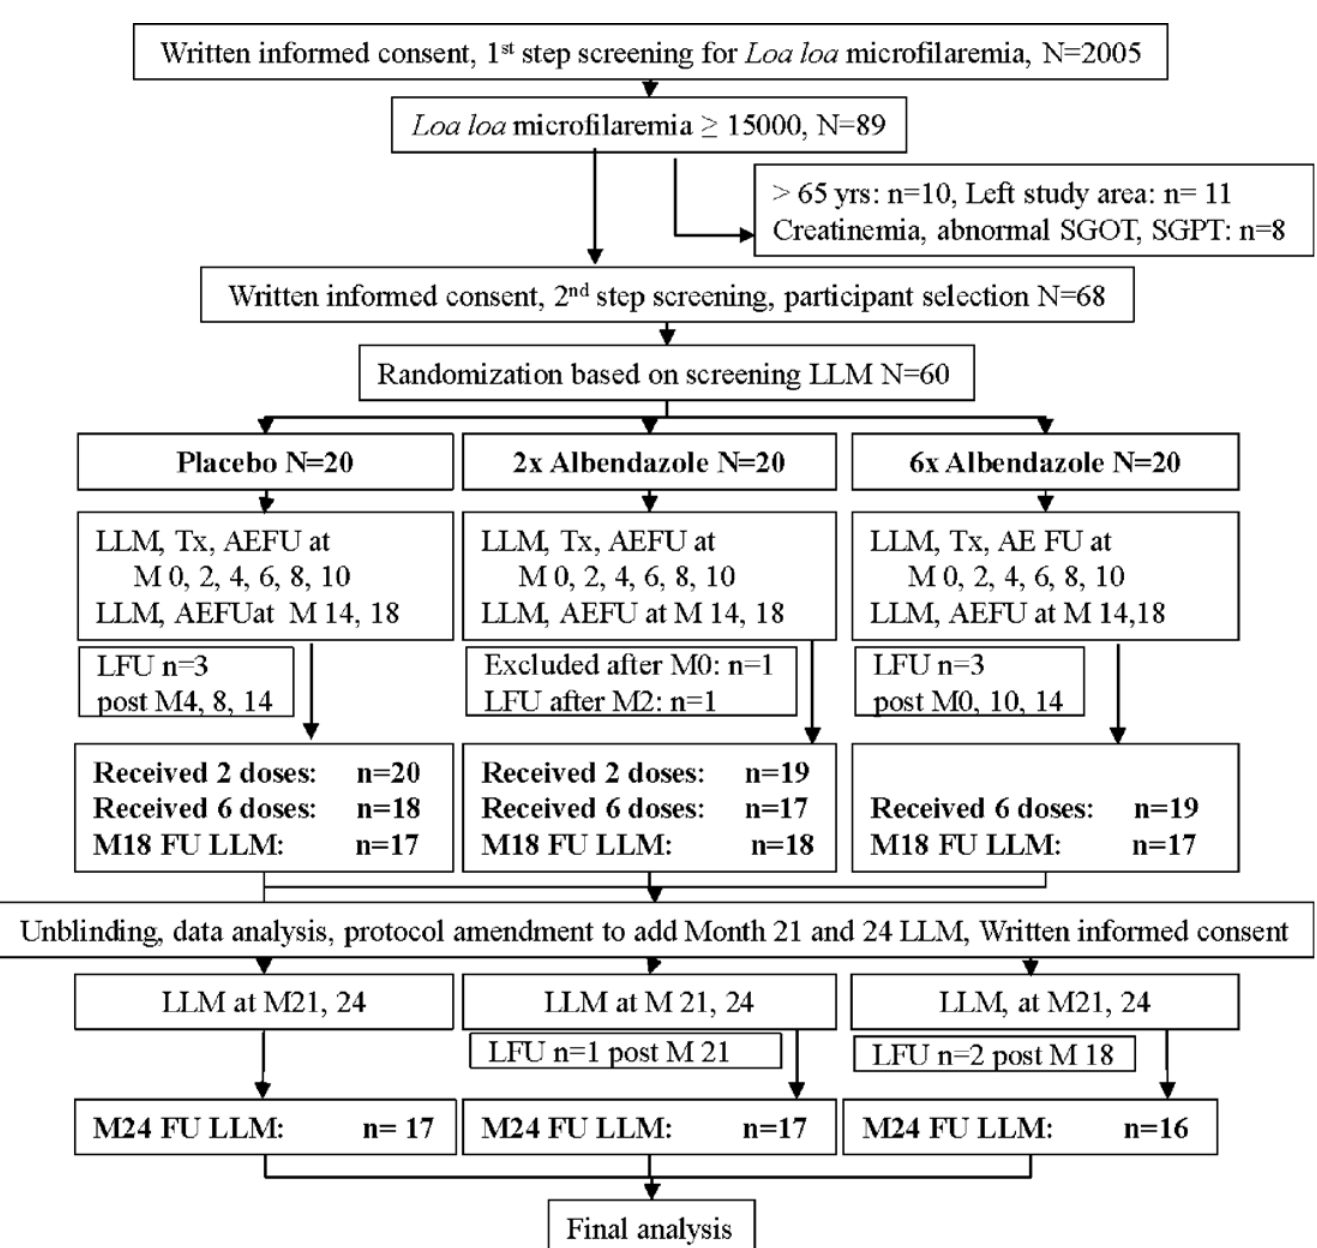
Fig 1. CONSORT flowchart. AE – adverse event, FU – follow up, M – Month, LLM — Loa loa microfilaraemia measurement, LFU – Lost to FU, Tx –